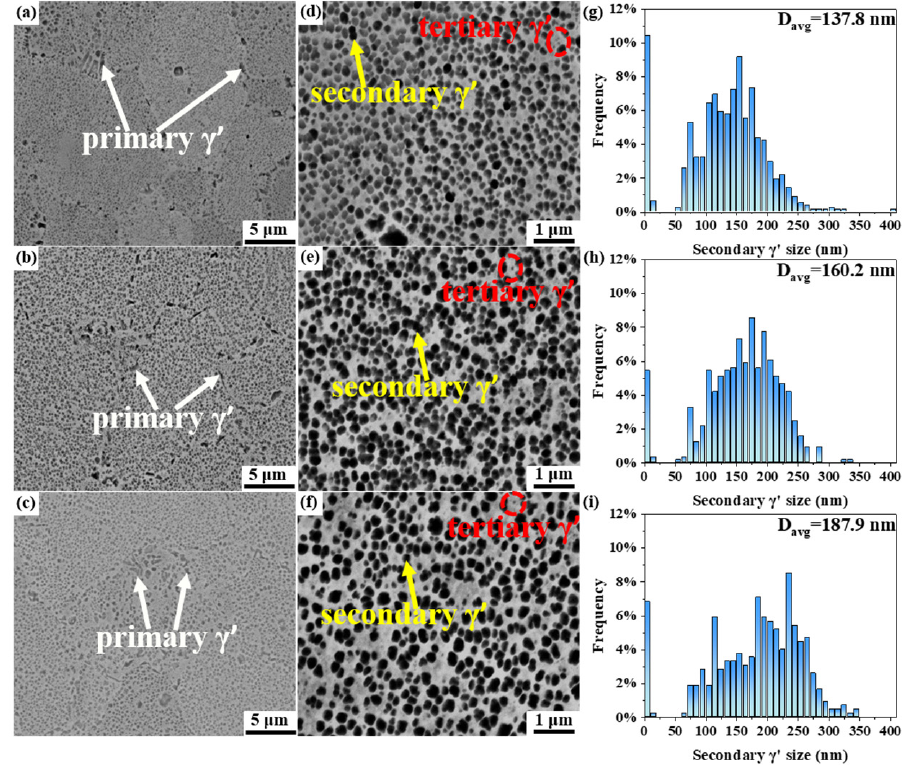
7 of 22 Figure 5. SEM image of Sc-doped RR1000 superalloy with relevant EDS analysis. ( a , b ) SE images of carbides in RR1000-0, ( c , d ) EDS analysis of carbides, ( e , f ) BSE images of Sc-rich phase in RR1000-0.064, ( g , h ) EDS analysis of Sc-rich phase. 3.3. Microstructure Evolution Figure 6 depicts the morphology and distribution of gamma prime γ ’ in U720Li with di ff erent scandium addition. As can be clearly seen, the distribution of γ ’ in U720Li is